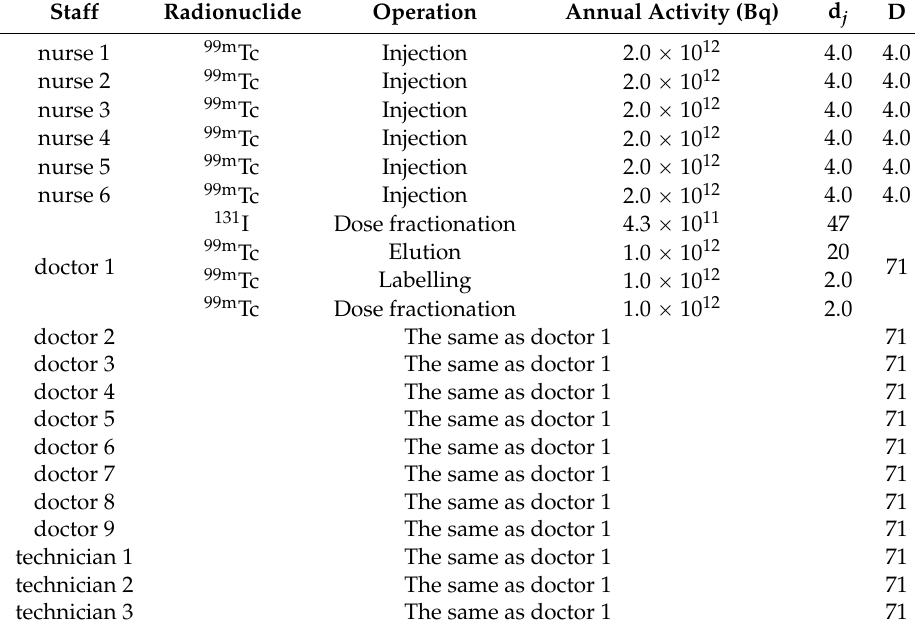
Table 6. d and D values of nuclear medicine staff in the selected specialized